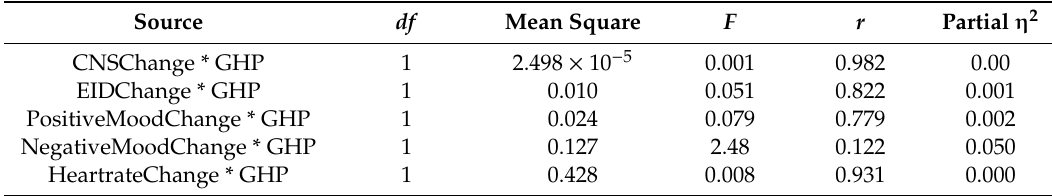
Table 2. Relationship statistics for GHP with five dependent